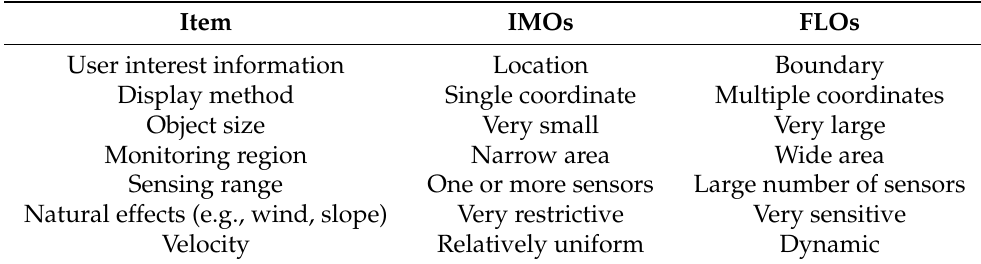
Table 1. Inherent characteristics of IMOs and